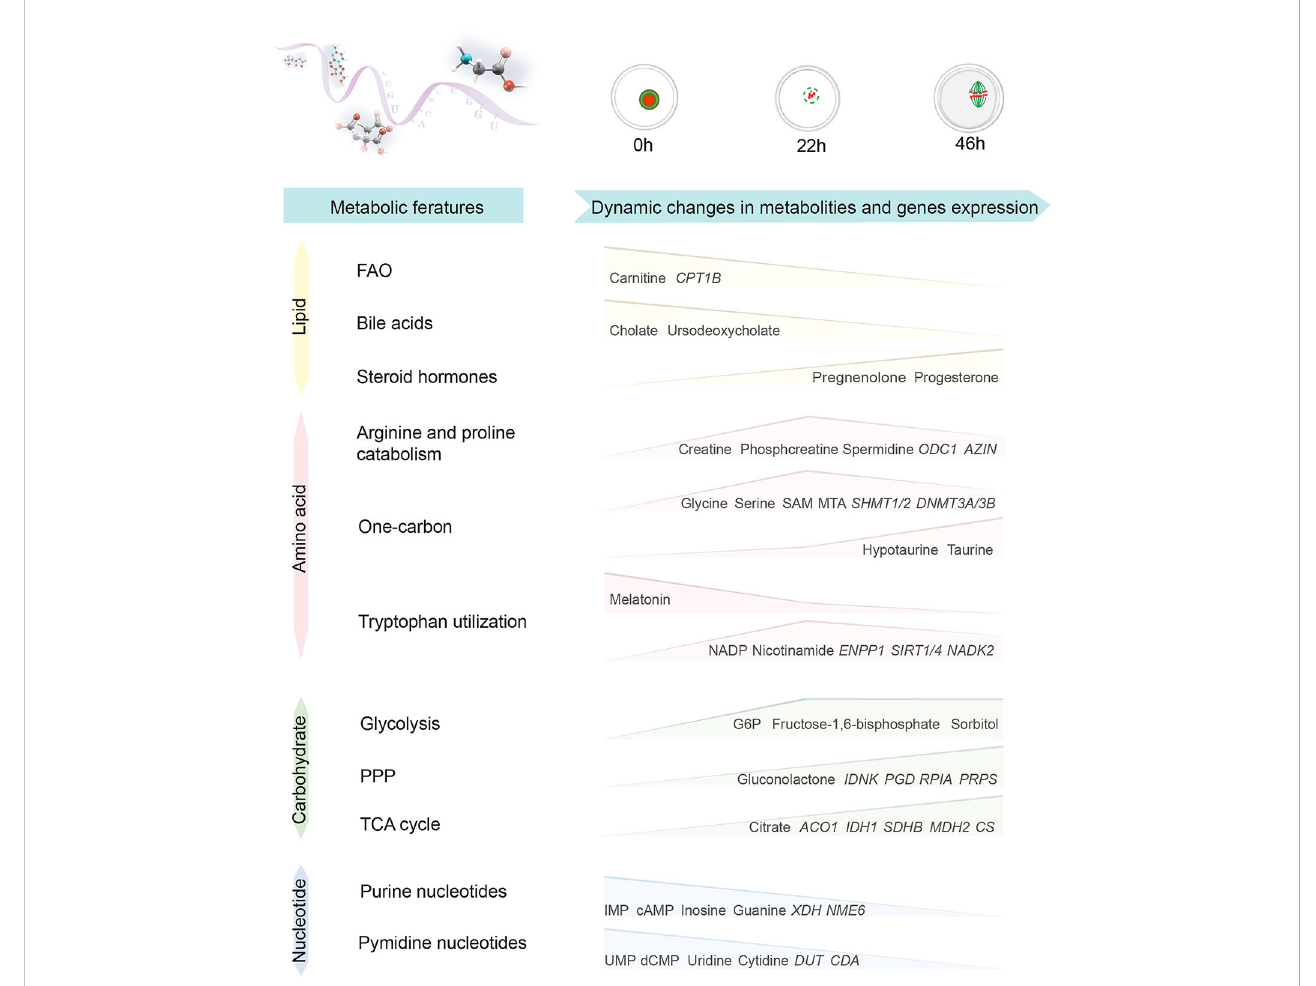
FIGURE 9 Characteristics of global metabolic patterns during porcine oocyte maturation. Diagram illustrating the dynamic changes in metabolites and gene expression during porcine oocyte